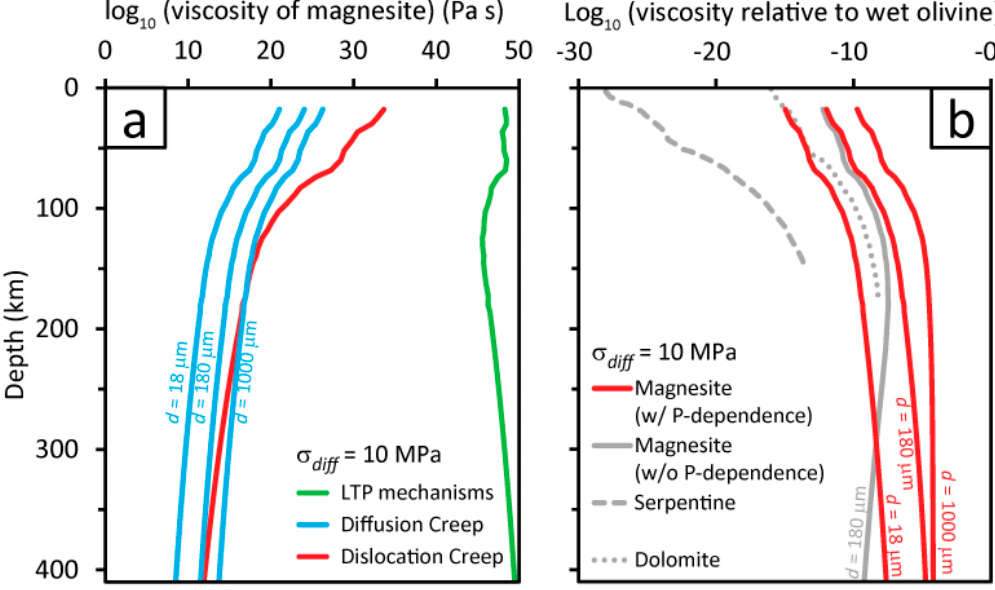
Figure 11. The viscosity of magnesite along the P-T path of subducting oceanic lithosphere [after [65] is dominated by diffusion creep when grain sizes are <1000 μ m, but dislocation creep becomes dominant at larger grain sizes ( a ). Recalculation of the magnesite flow laws of [17] to include the pressure dependence of the strengths of each deformation mechanism does not significantly change the implications of their model ( b ). The strength of magnesite is greater when pressure dependence is included, but magnesite is still at least five orders of magnitude weaker than wet olivine at all conditions along the P-T path of subducting oceanic lithosphere. Serpentine – [5]; Dolomite – [54,58]; Magnesite without pressure dependence – [17]; Magnesite with pressure dependence – this study; wet olivine – [67].